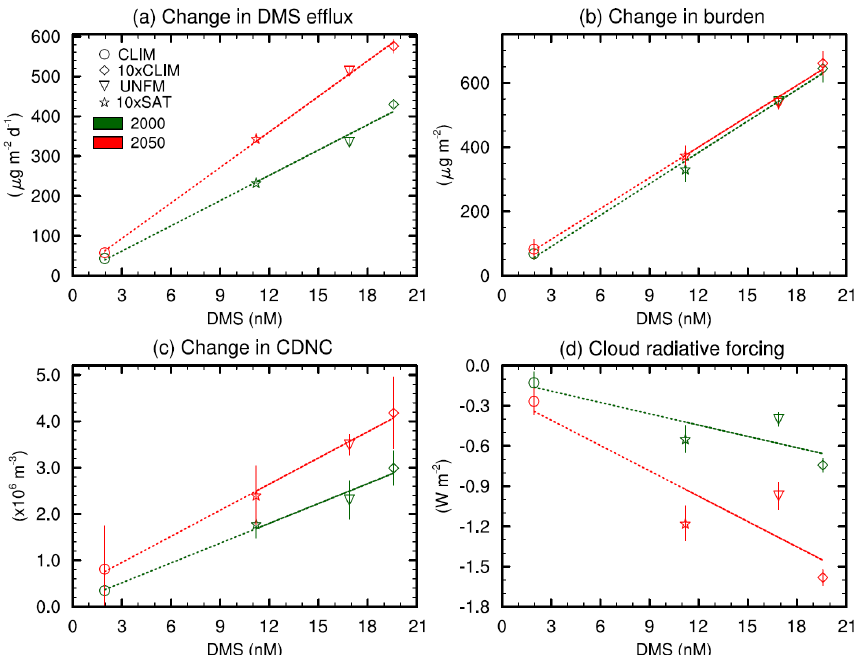
Figure 8. Relationship between annual Arctic mean DMS emission fluxes, sulfate burden, CDNC, and cloud forcing and the mean DMS concentration in the Arctic. The vertical lines represent 95% confidence interval based on a two-tailed t test. Dotted lines represent the regression between the four